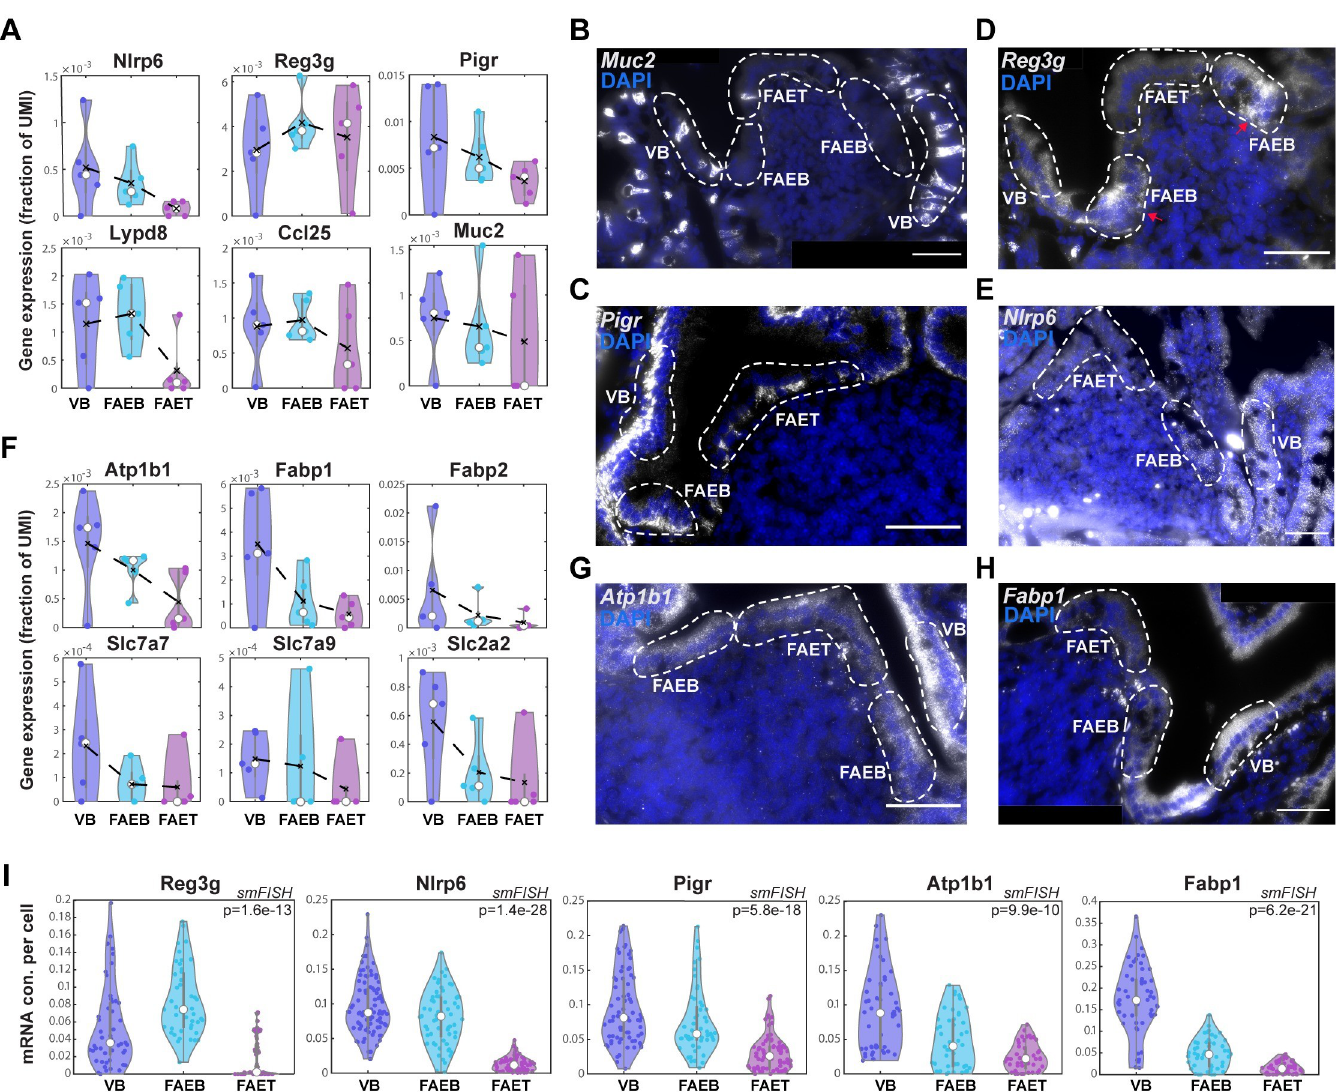
Fig 2. Down-regulation in antimicrobial and absorption expression programs. ( A, F ) Violin plots of LCMseq gene expression (fraction of UMI) showing down- regulated expression of antimicrobial genes ( A) Nlrp6 , Reg3g , Pigr , Lypd8 , Ccl25 , and Muc2 and nutrient absorption genes ( F) Atp1b1 , Fabp1 , Fabp2 , Slc7a7 , Slc7a9 , and Slc2a2 in FAET compared to FAEB and VB. Black dashed lines represent mean values; white dots represent median values of 5 repeats of at least 3 individual FAE from 2 mice. Gray boxes delineate the 25–75 percentiles. Kruskal–Wallis p > 0.05 for the genes in A, F . ( B-E, G-H ) Representative smFISH images showing decreased expression of Muc2 ( B ), Pigr ( C ), Reg3g ( D ), Nlrp6 ( E ), as well as Atp1b1 ( G ) and Fabp1 ( H ) in FAET compared to FAEB and VB. Reg3g reduced expression in FAET is compensated by higher expression in FAEB, marked with red arrows. White dashed lines delimit FAET, FAEB, and VB areas. DAPI staining for cell nucleus in blue. Scale bar: 50 μ m. ( I ) Violin plots of dot quantifications of smFISH of Reg3g , Nlrp6 , and Pigr , as well as Atp1b1 and Fabp1 (analysis performed over 4 mice with 3–5 individual ILF/FAEs per mouse). White dots are median values; gray boxes delineate the 25–75 percentiles. The data used to generate this figure can be found in Supporting information S2 and S5 Data. FAE, follicle-associated epithelium; FAEB, FAE bottom; FAET, FAE top; ILF, isolated lymphoid follicle; ILFB, ILF bottom; ILFT, ILF top; smFISH, single-molecule fluorescence in situ hybridization; UMI, unique molecular identifier; VB, villus bottom.